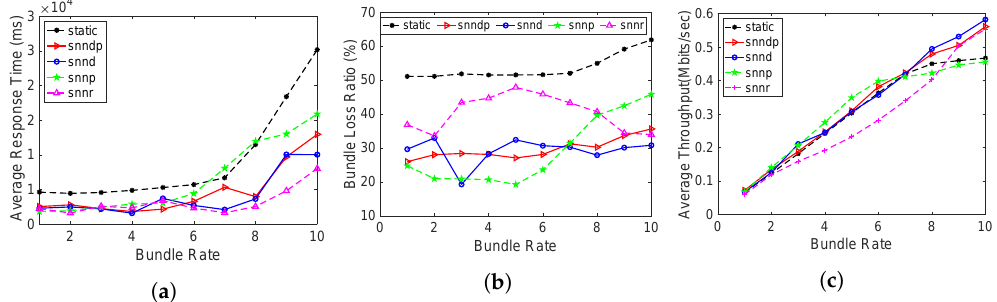
Figure 16. Routing performance: Scenario 8. ( a ) Average response time; ( b ) Packet loss ratio (%); ( c )